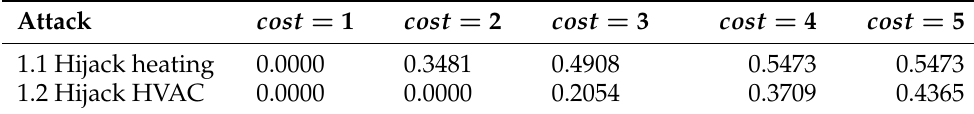
Table 10. Smart home and HVAC hijack use case risk exposure